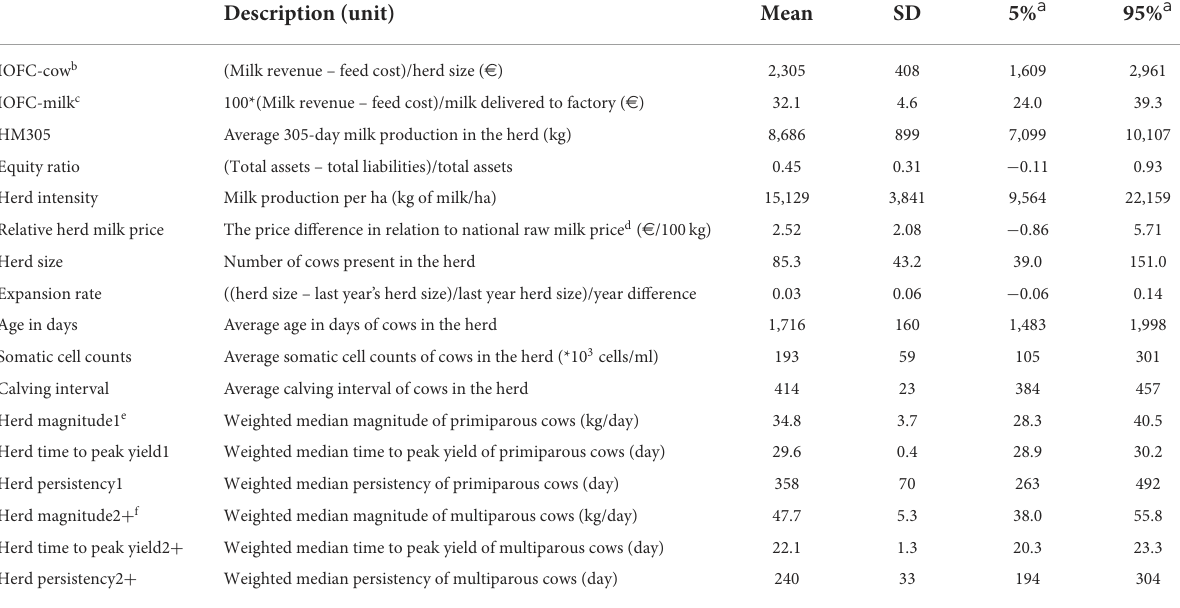
TABLE 1 Descriptive statistics of continuous variables over 1,664 Dutch herds for the years 2008–2015.